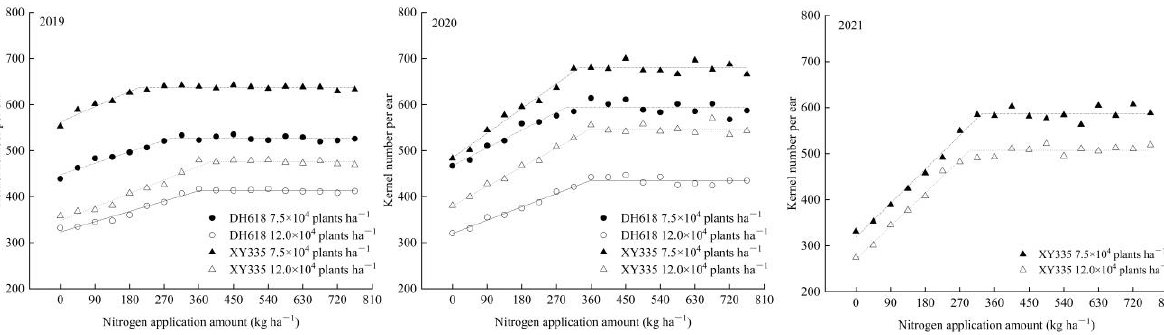
Figure 3. Effects of different nitrogen application rates on the kernel number per ear of maize.